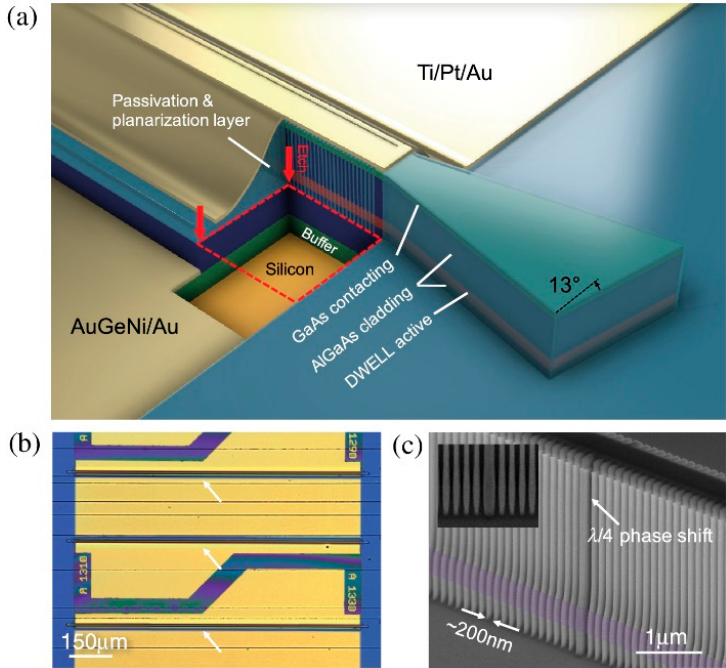
Figure 20. DFB laser array on silicon. ( a ) Cutaway schematic of the DFB lasers (not to scale). ( b ) Regional microscope image of the DFB laser array on silicon. ( c ) High-resolution SEM image of the gratings with a λ ∕ 4 phase shift in the middle from a test run. Reproduced with permission from [174]. The Optical Society, 2018.